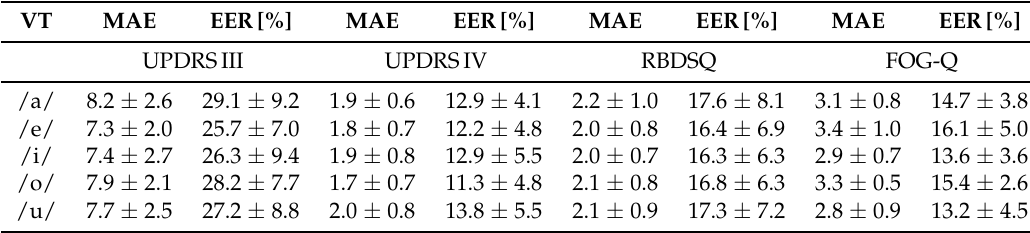
Table 5. Results of the clinical scales’